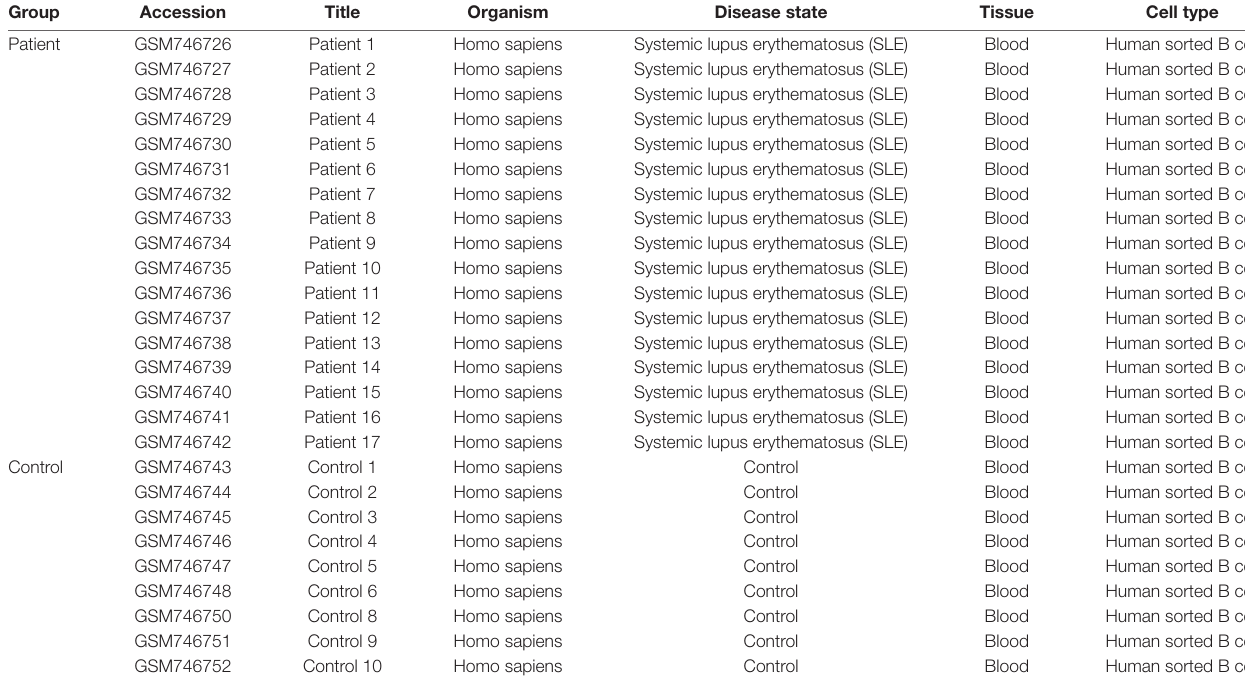
TABLE 1 | The primary characteristics of 26 studies in GSE30153 procured from the Gene Omnibus Expression database. Group